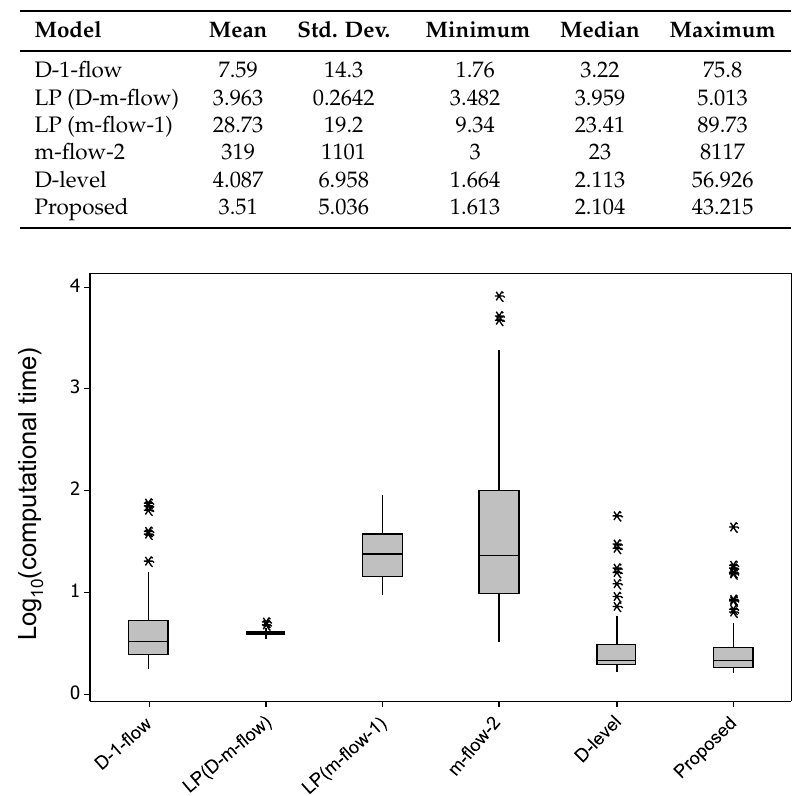
Table 2. Descriptive statistics of the computational times in seconds for the 30-node instances.